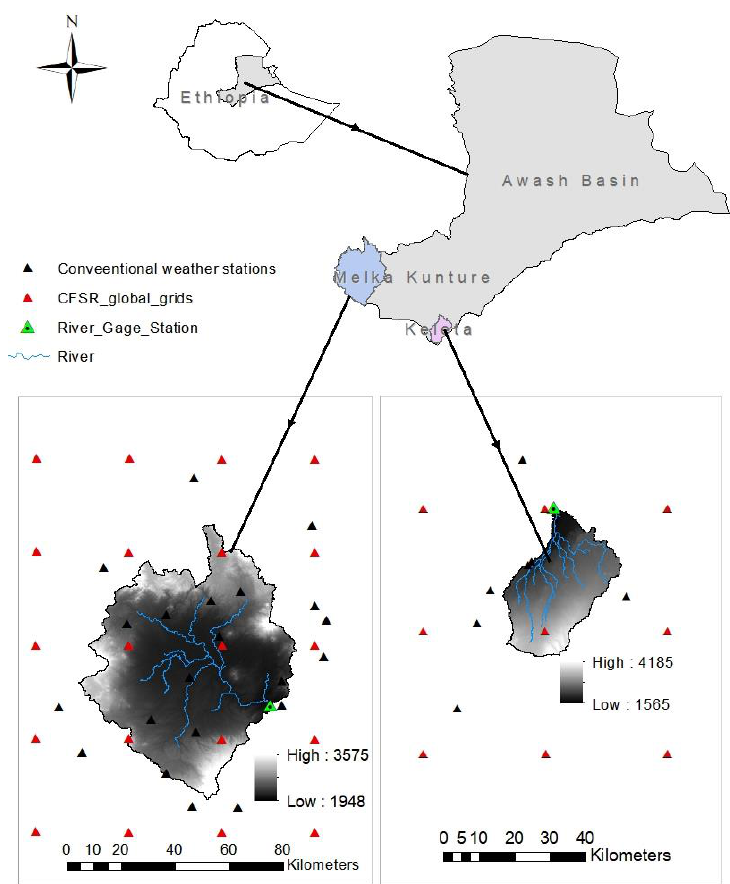
Figure 1. Map of Melka Kunture ( left ) and Keleta ( right ) sub-basins with conventional weather stations, Climate Forecast System Reanalysis (CFSR) grids, river gauge stations, digital elevation maps (DEM), and river networks.